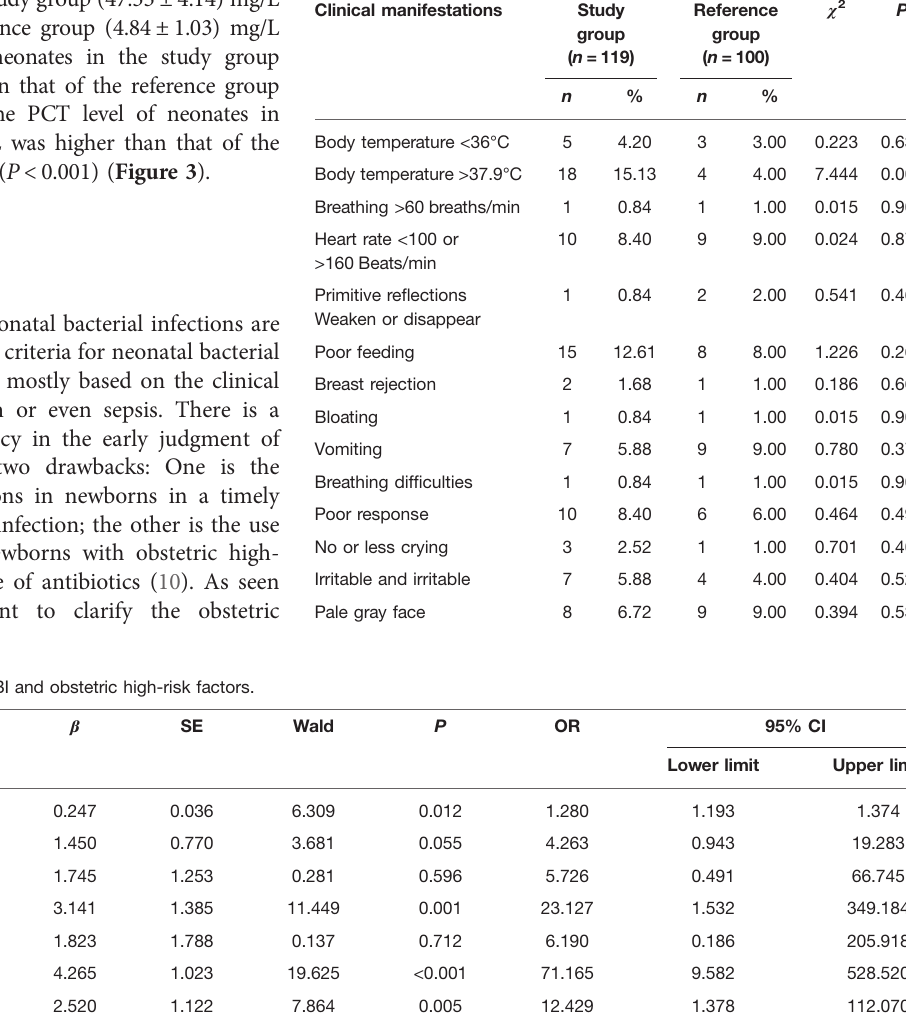
TABLE 3 | Analysis of clinical manifestations in two groups of newborns.